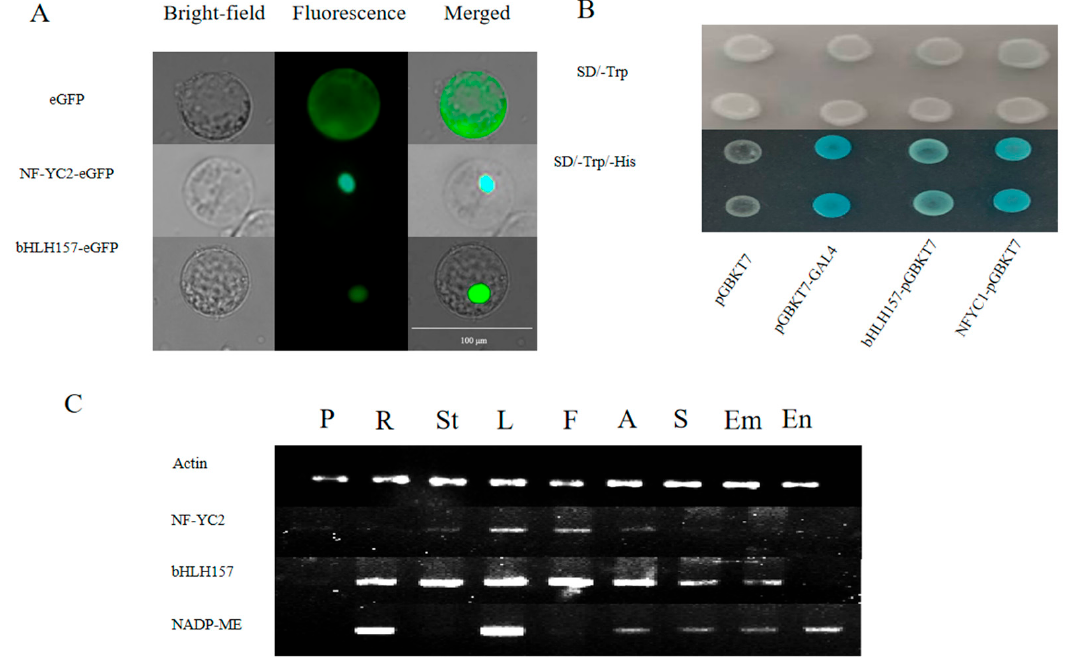
Figure 4. bHLH157 and NF-YC2 transcription factor functional verification. ( A ) Subcellular localiza- tion. ( B ) Yeast self-activation, pGBKT7, was the negative control and pGBKT7-GAL4 was the positive control. ( C ) Semi-quantitative, (roots, R), stems (St), leaves (leaves, L), filaments (F), anthers (A), pollen (pollen, P), post-pollination seeds (S), embryos (Em), and endosperm (En).